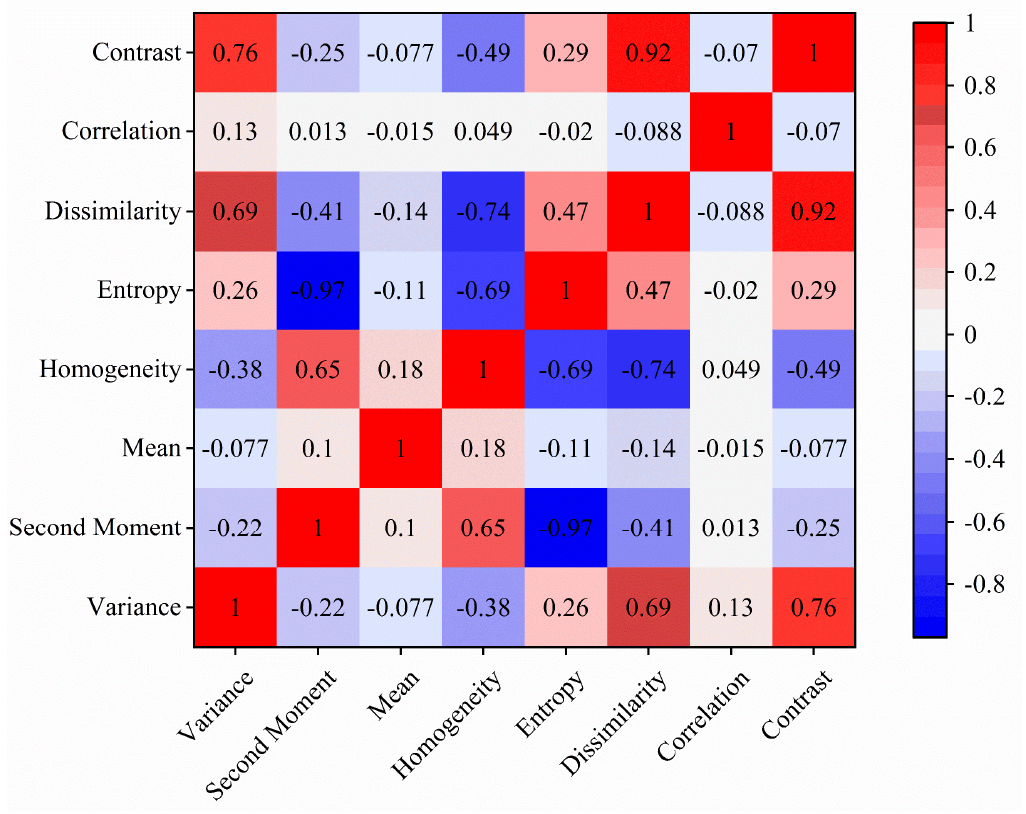
Figure 4. Correlation coefficients between texture features.